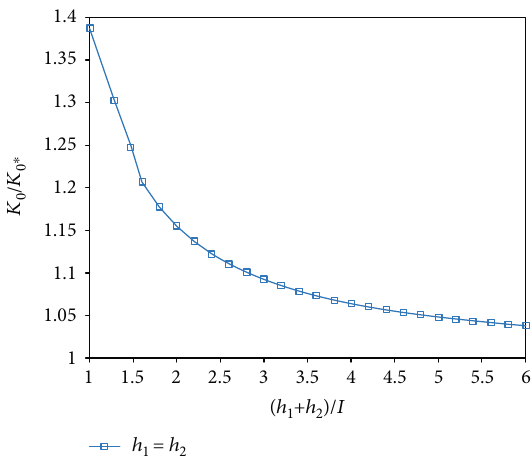
Þ / l on thermal fl ow intensity factor for + h 1 2